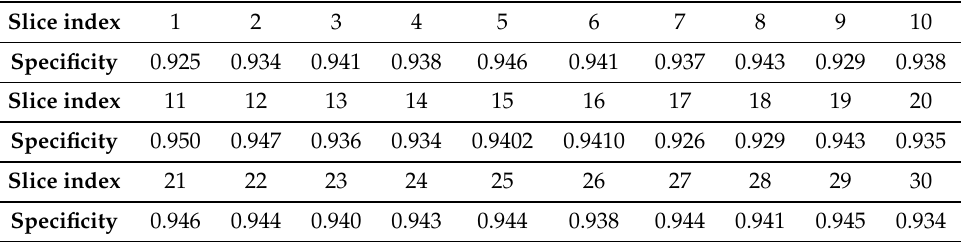
Table 3. Specificity measures obtained on several different samples of brain tumor from the dataset in Reference